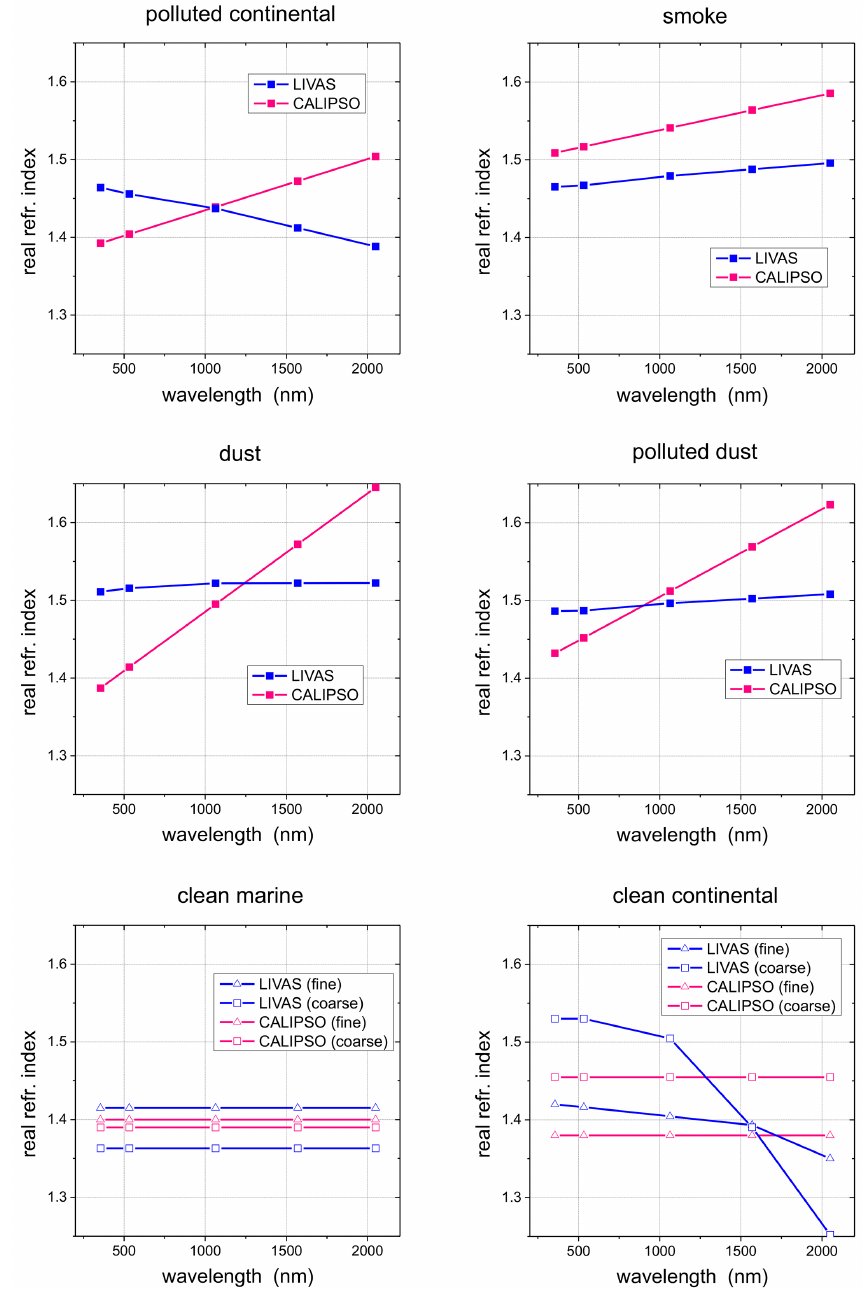
Figure 4. Comparison of the mean real part of the refractive index for each aerosol type in the LIVAS (blue line) and CALIPSO (pink line) aerosol